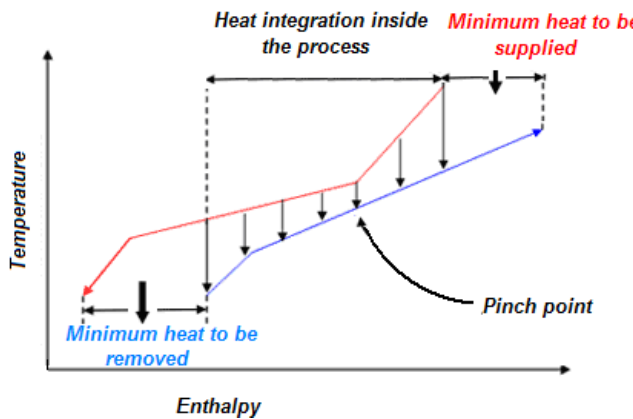
Figure 1. Hot and cold composite curves of a generic